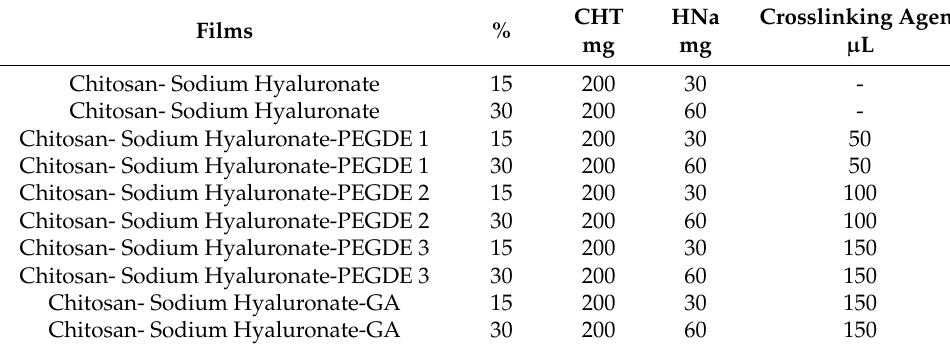
Table 1. Composition of chitosan (CHT) films, CHT/HNa at 15% and 30% films crosslinked with glutaraldehyde (GA) and polyethylene glycol diglycidyl ether